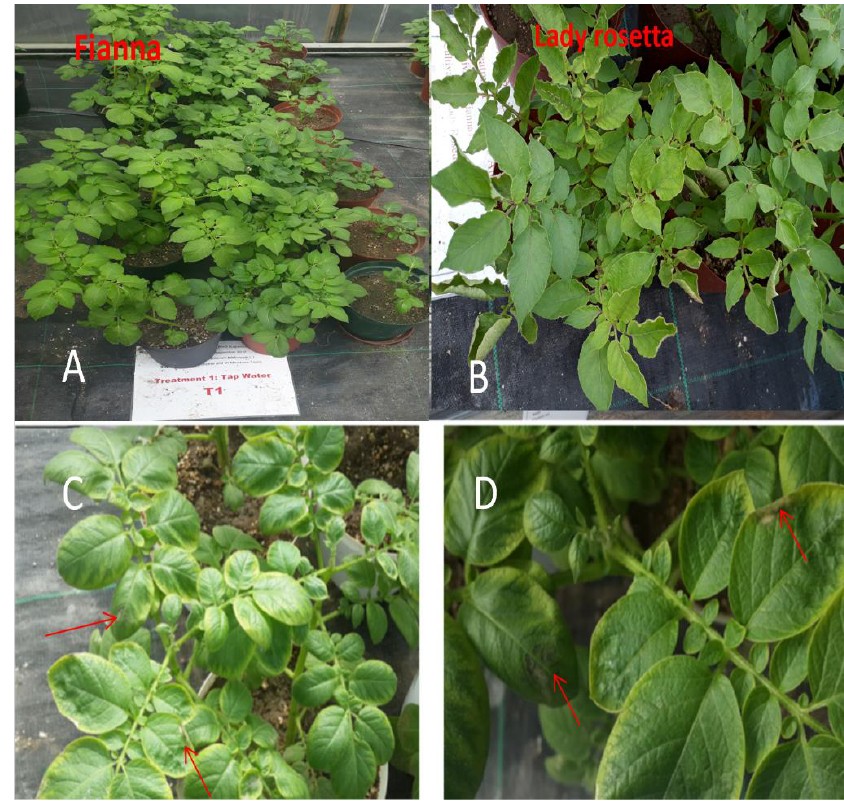
Figure 1. Experimental layout in greenhouse ( C ) and symptoms of metal toxicity ( D ) (initiation of discolouration in leaf margins) in both cultivars ( Fianna ( A ) and Lady rosetta ( B )), exposed to irrigation with FA-treated AMD treatments.